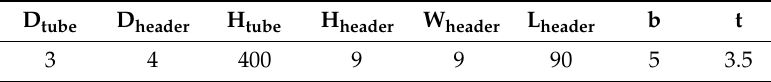
Table 1. Geometric sizes of the benchmark test model (units: mm).